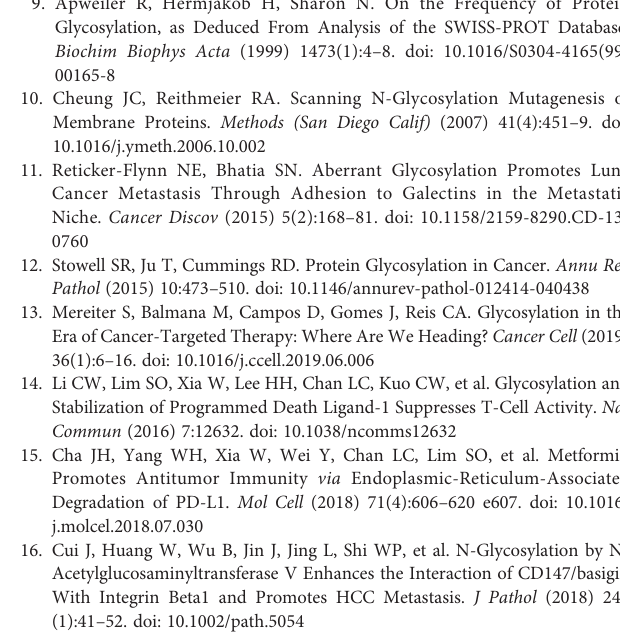
Supplementary Figure 1 | TIM-4 is heterogeneous and evolutionarily conserved in NSCLC. (A) Western Blot was used to detect the expression of TIM-4 in lung cancer tissues before and after PNGase F treatment. (B) Western Blot was used to detect the expression of endogenous TIM-4 in lung cancer cell line before and after TM treatment. (C) Western Blot was used to detect the half-life of TIM- 4.Quanti fi cation of TIM-4 half-life was shown in (D) . (E) Western Blot was used to detect the expression of TIM-4 in lung cancer tissues. (F) Sequence alignment of the TIM-4 amino acid sequences from different species. Supplementary Figure 2 | FUT4 was correlated with TIM-4 in human NSCLC tissues. (A) Correlation between the RNA expression of TIM-4 and FUT4 in TNBC. (B) Correlation between the protein expression of TIM-4 and the RNA expression of FUT4 in lung cancer patient